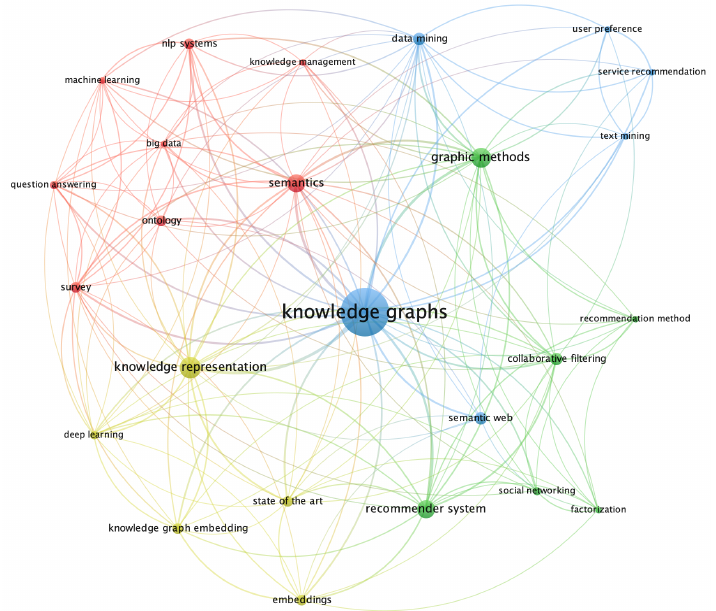
Figure 3. Network of more relevant keywords related to the selected papers.